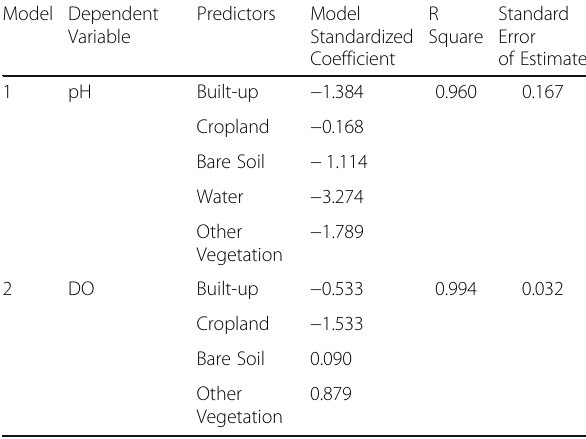
Table 3 Regression Model Summary for pH and DO Model Dependent